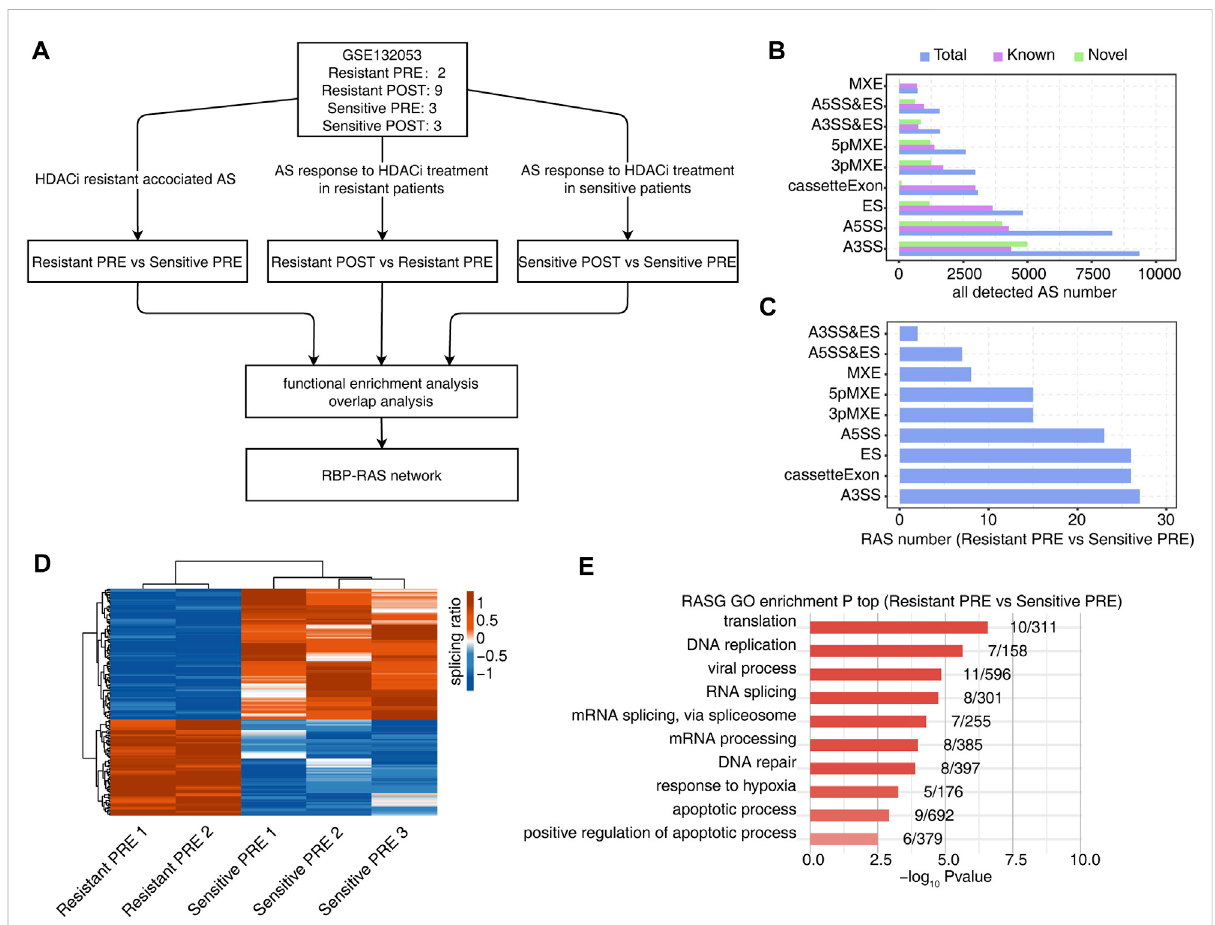
FIGURE 1 Identi fi cation of regulated AS events (RAS) between HDACi resistant and sensitive samples of peripheral blood from MF/SS patients before treatment with HDACi. (A) Work fl ow of bioinformatic analysis in this study. (B) The bar plot showing the number of all detected alternative splicing events (ASEs). X -axis: All ASE number. Y -axis: the different types of AS events. (C) The bar plot showing the number of all signi fi cant regulated alternative splicing events between Resistant PRE and Sensitive PRE samples. X -axis: NIR RASE number. Y -axis: the different types of AS events. (D) Hierarchical clustering heatmap of all signi fi cant RAS based on splicing ratio of Resistant PRE and Sensitive PRE samples. (E) Bar plot showing the most enriched GO biological process results of the NIR RAS between Resistant PRE and Sensitive PRE